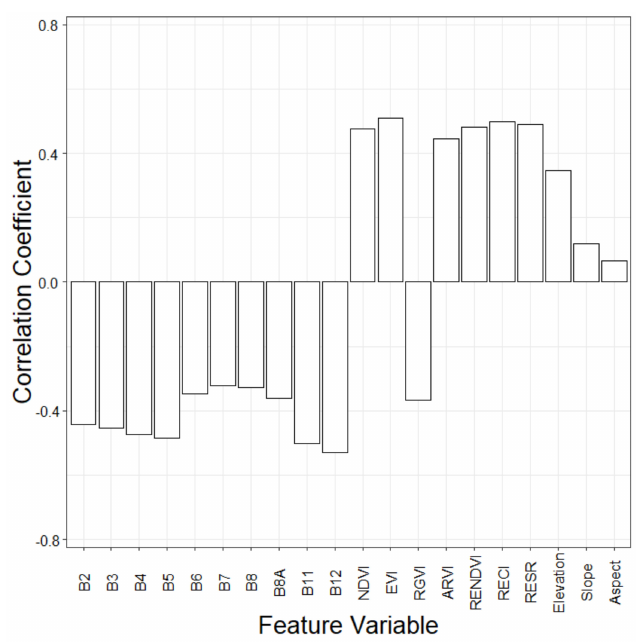
Figure 3. Correlation coe ffi cients of the extracted feature variables with GSV.